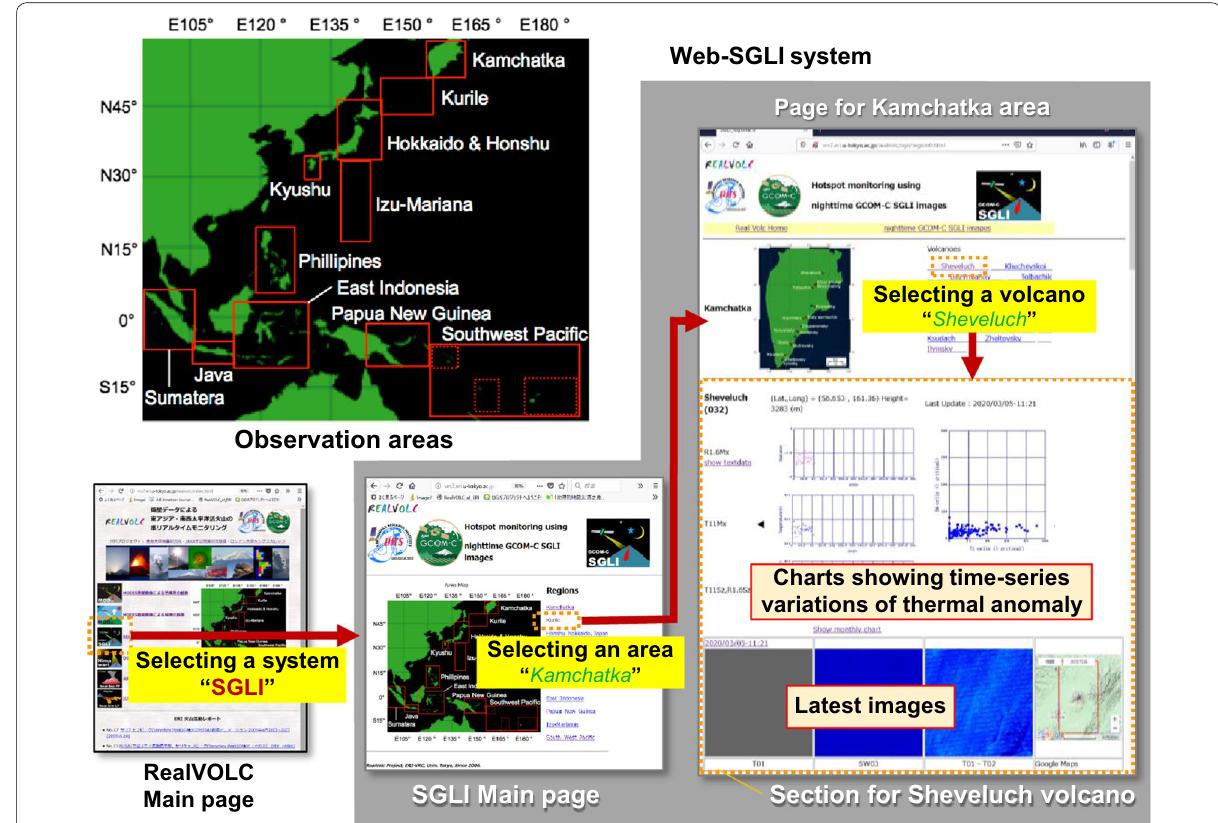
Fig. 7 Overview of the prototype web system for real-time monitoring using SGLI